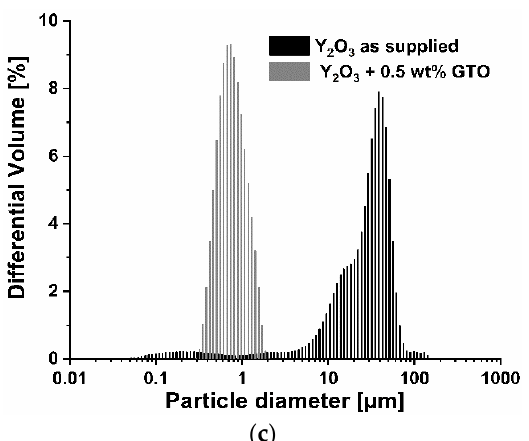
Figure 2. Particle size distribution of ( a ) AlN, ( b ) Al 2 O 3 , ( c ) Y 2 O 3 treated with 0.5 wt % of GTO. Table 3. Particle size distribution of powders with ( + ) and without ( − ) dispersing agent